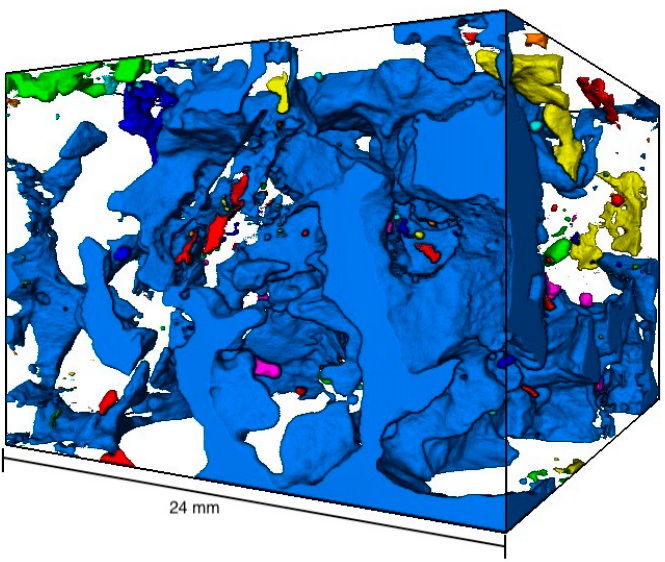
Figure 9. Visualized void distribution of the µ-CT scan—porous asphalt; volume: 48,593.1 mm 3 .